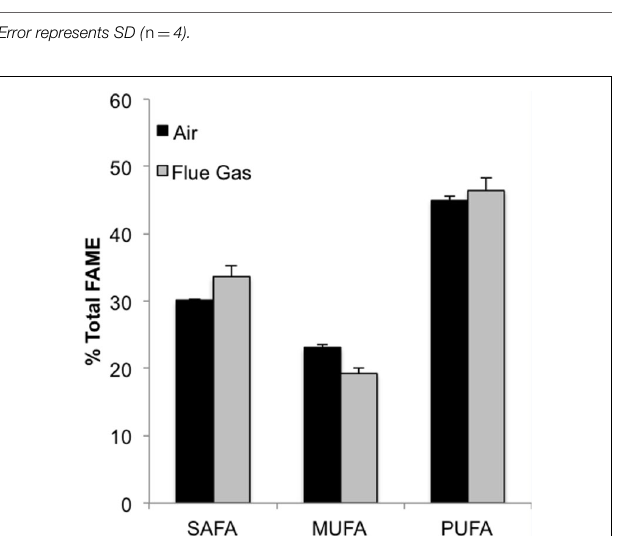
FIGURE 2 | Classification of fatty acid saturation as a percentage of total fatty acid methyl esters (FAMEs) for Heterosigma akashiwo bubbled with air (control) or simulated flue gas containing 12% CO 2 and 150ppm NO . SAFA, saturated fatty acids; MUFA, monounsaturated fatty acids; PUFA, polyunsaturated fatty acids. Data plotted are mean values ± SD ( n = 4).